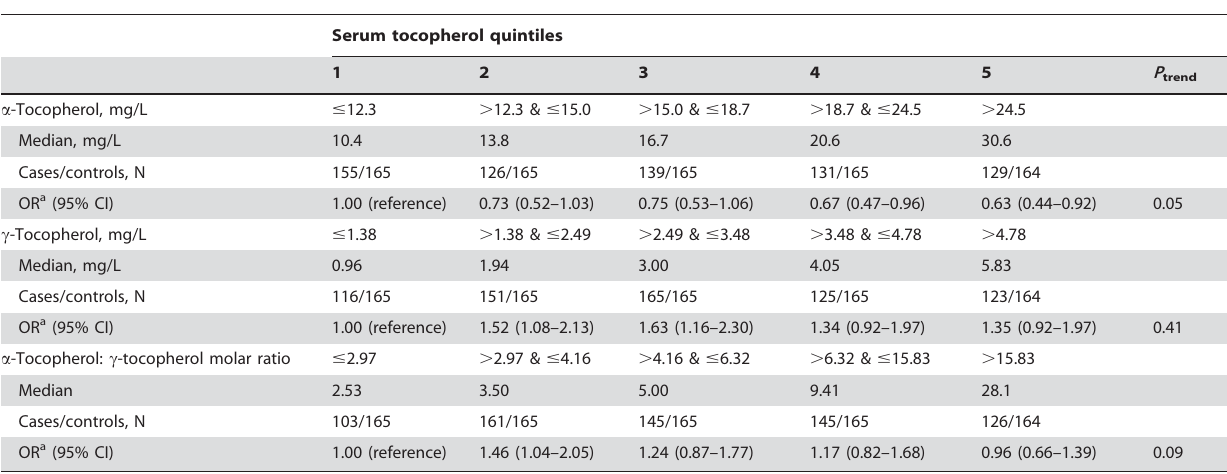
Table 3. Association between baseline serum a -tocopherol, c -tocopherol, and the a -tocopherol: c -tocopherol molar ratio and risk of prostate cancer, PLCO